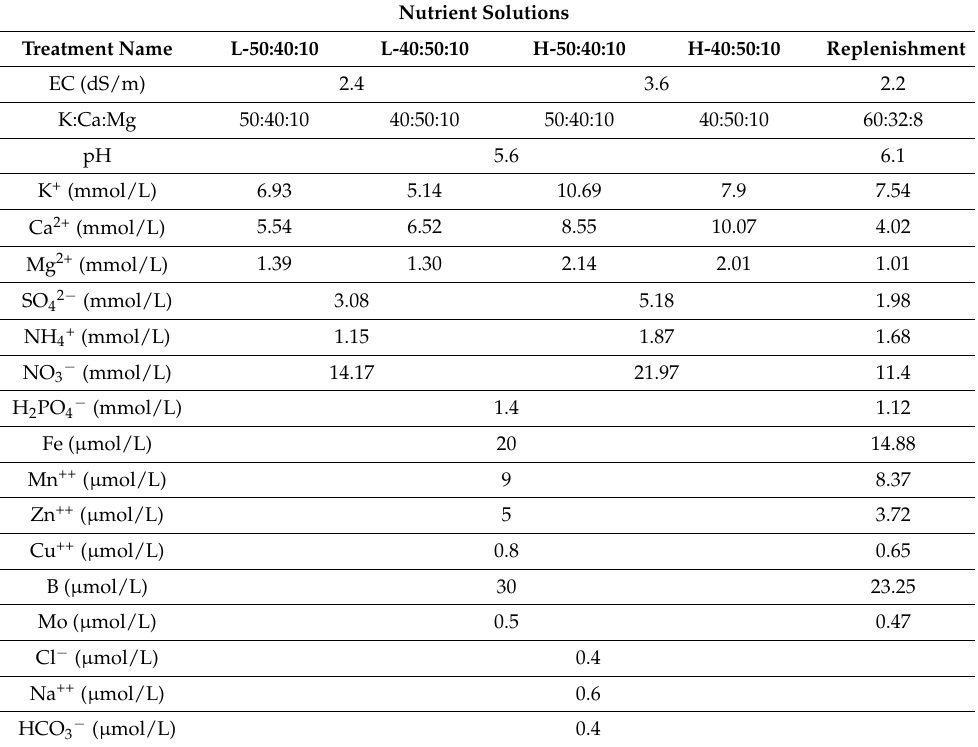
Table 1. Composition of the 4 nutrient solutions and the replenishment solution. Nutrient